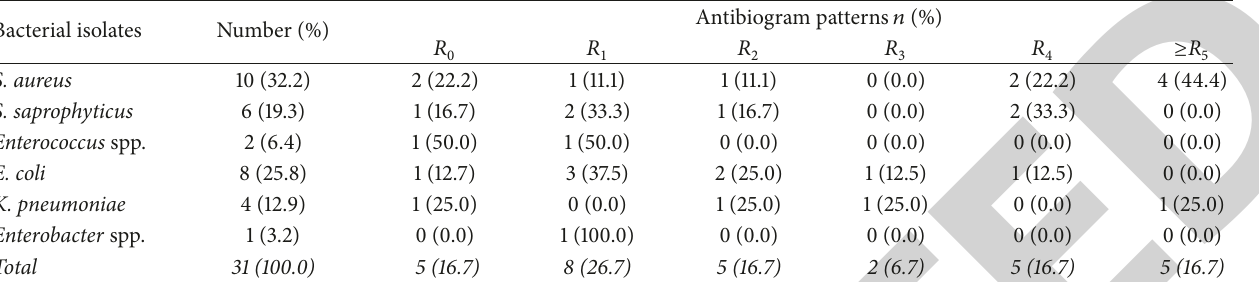
Table 9: Multiple antimicrobial resistance pattern of bacterial isolates from urine of diabetic and nondiabetic patients attending Debre Tabor Hospital, Northwest Ethiopia,